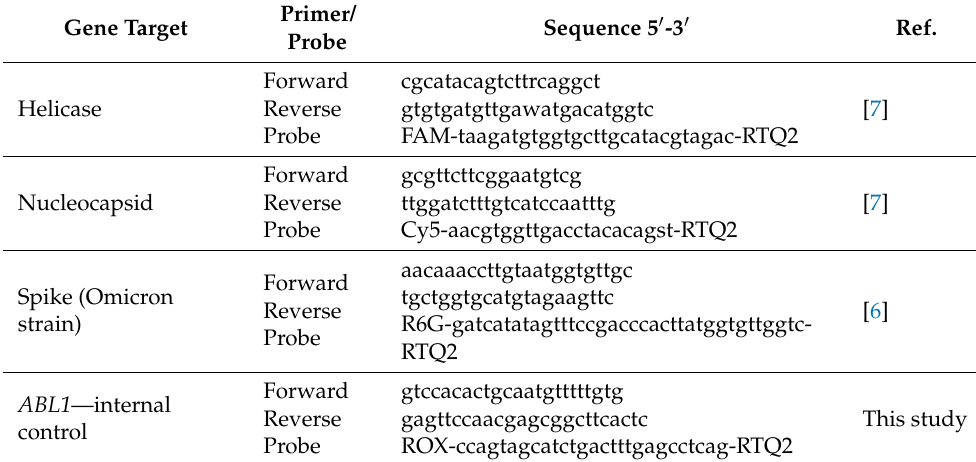
Table 1. Primers and fluorescent Taqman